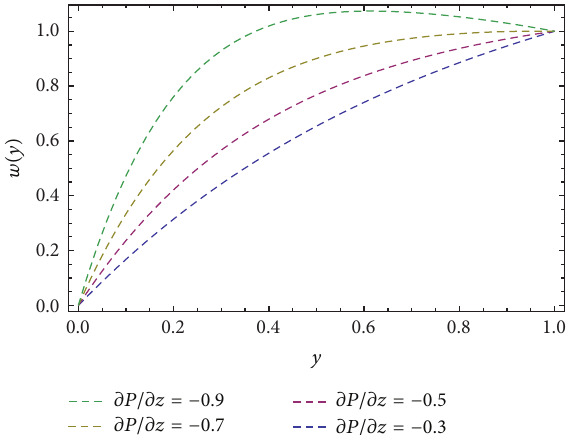
Figure7:Velocityprofile 𝑤(𝑦) fordifferentvaluesof 𝜕𝑃/𝜕𝑧 ,keeping 𝛼 = 1.0 , 𝛽 = 1.0 , and 𝜙 = 45 ∘